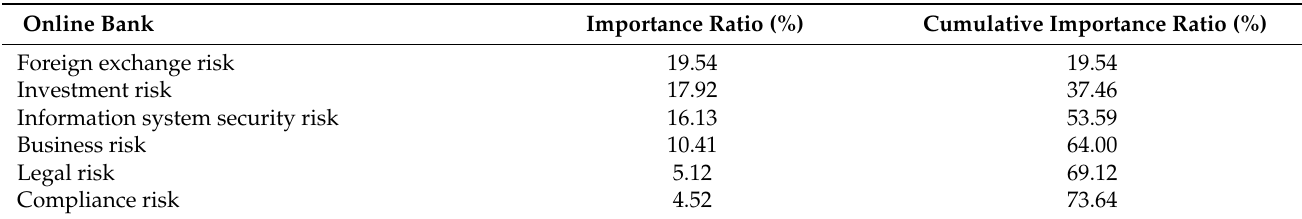
Table 11. The importance ratios of risks faced by the online bank industry from 2015 to